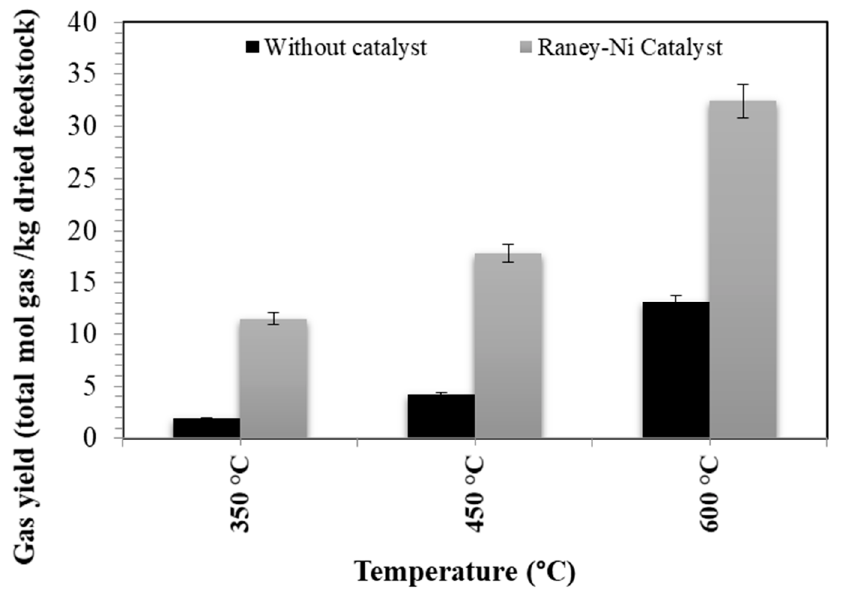
Figure 4. Effect of the temperature on total gas